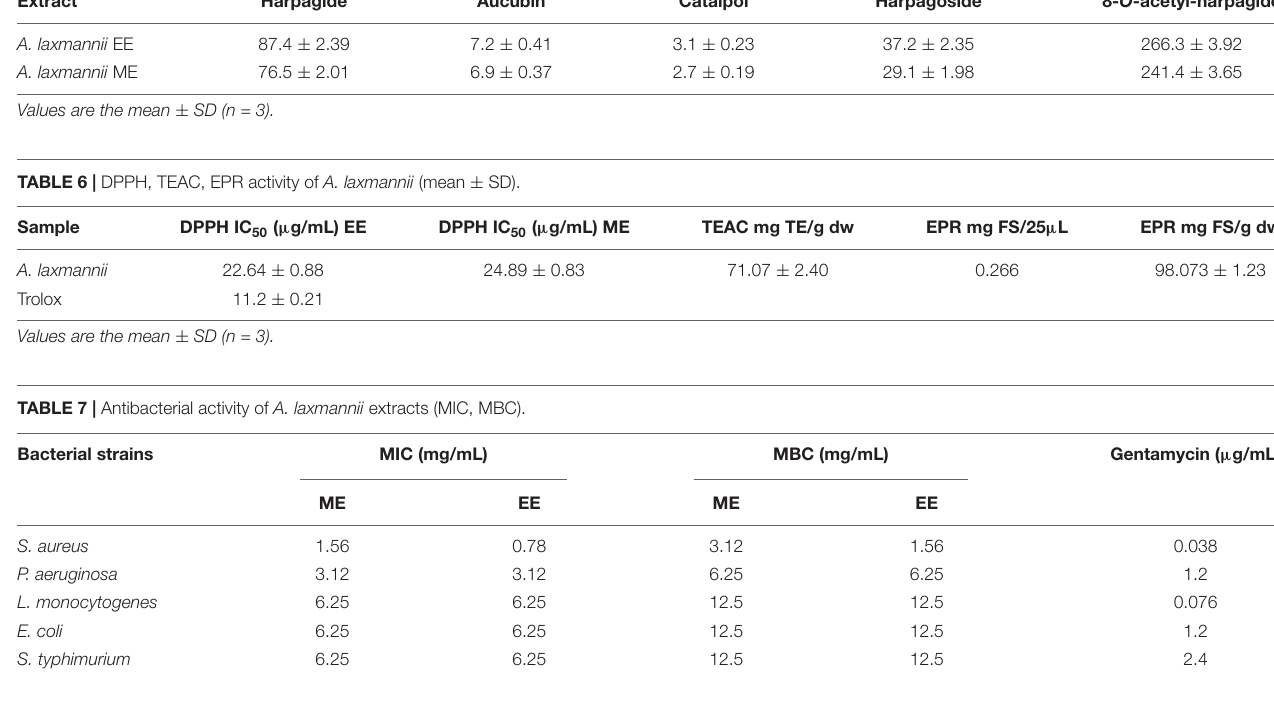
TABLE 5 | The quantification of iridoids in A. laxmannii extracts ( µ g/mL extract). Extract